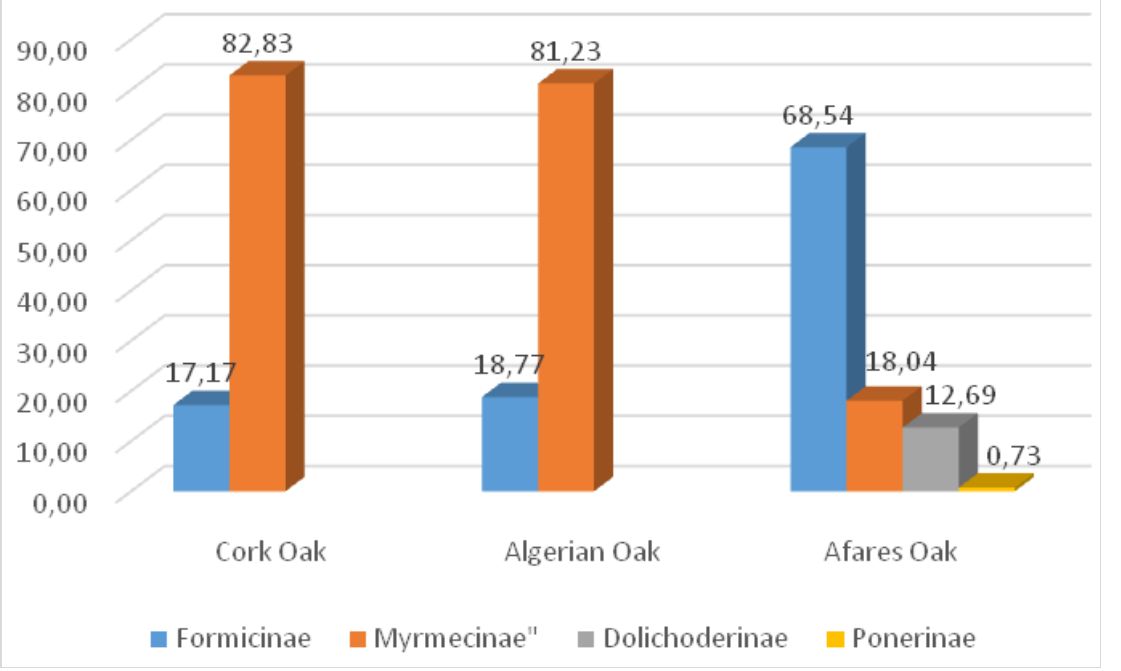
Fig 3 . Formicidae centesimal frequencies of grouped by sub-family in the three study stations